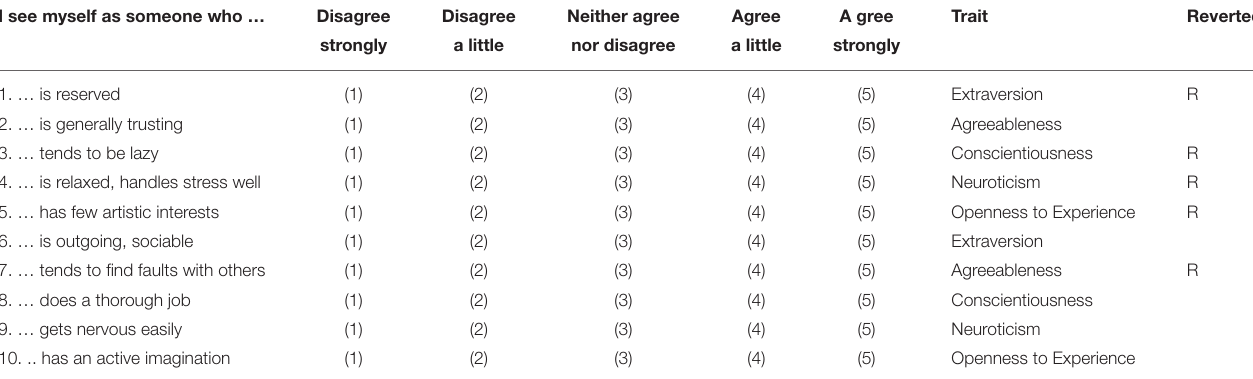
TABLE 3 | BFI-10 instrument used, and its scoring: the trait for which each item was used and whether it was reverse scored (R) 7 . I see myself as someone who